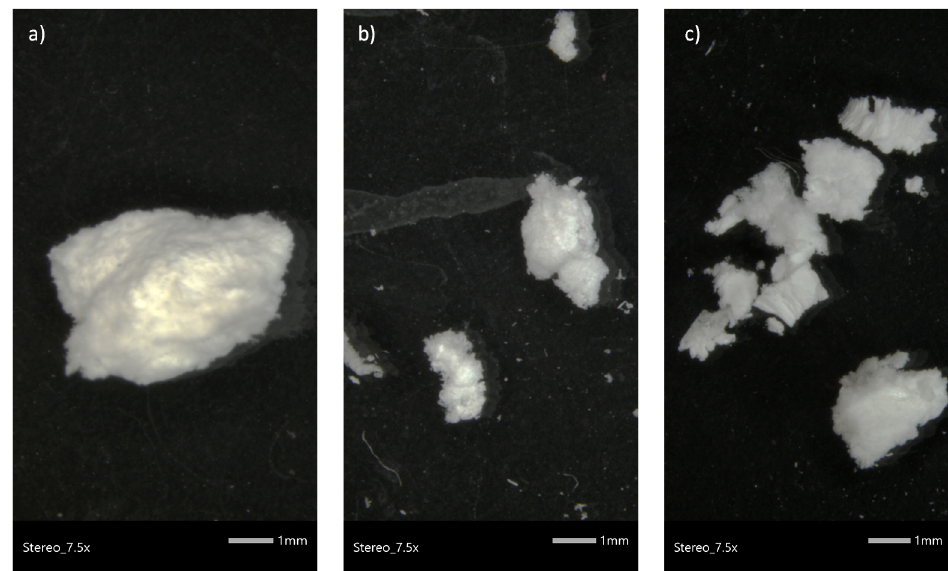
Figure 4. Stereo microscope images of the drug loaded sponges: ( a ) PVA/CNF/CHL 10 wt%, ( b ) PVA/CNF/CHL 20 wt%, and ( c ) PVA/CNF/CHL 30 wt%.